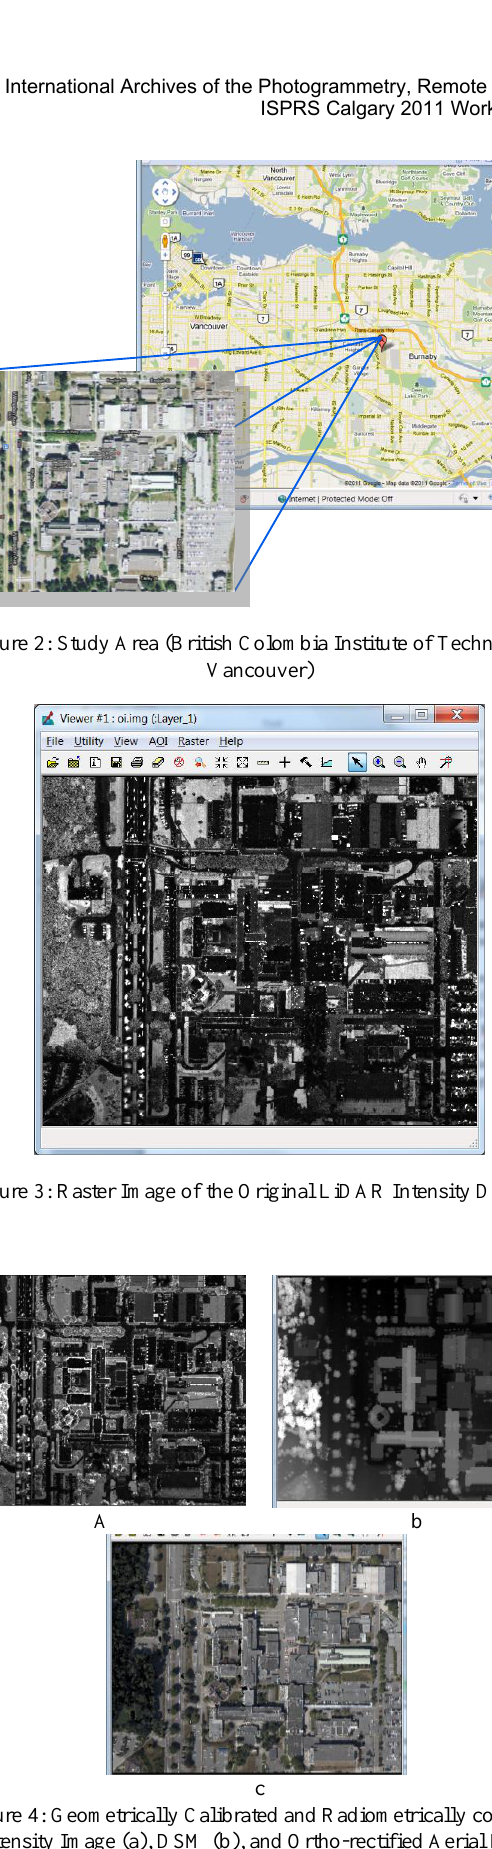
Figure 4: Geometrically Calibrated and Radiometrically corrected Intensity Image (a), DSM (b), and Ortho-rectified Aerial Photo (c)